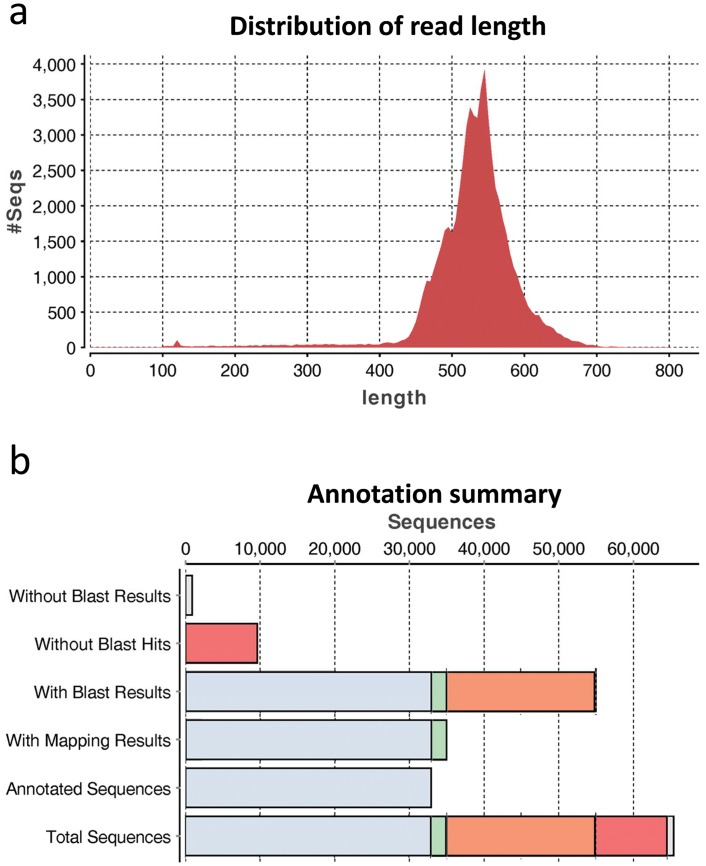
Overview of functional annotation results of Atlantic cod fast skeletal muscle transcriptome.Analysis was performed by Blast2GO-PRO software. a) Distribution of annotated sequence reads to UniGene cDNA reference data. b) Functional annotation results of Atlantic cod fast skeletal muscle transcriptome annotated to UniGene cDNA reference data.